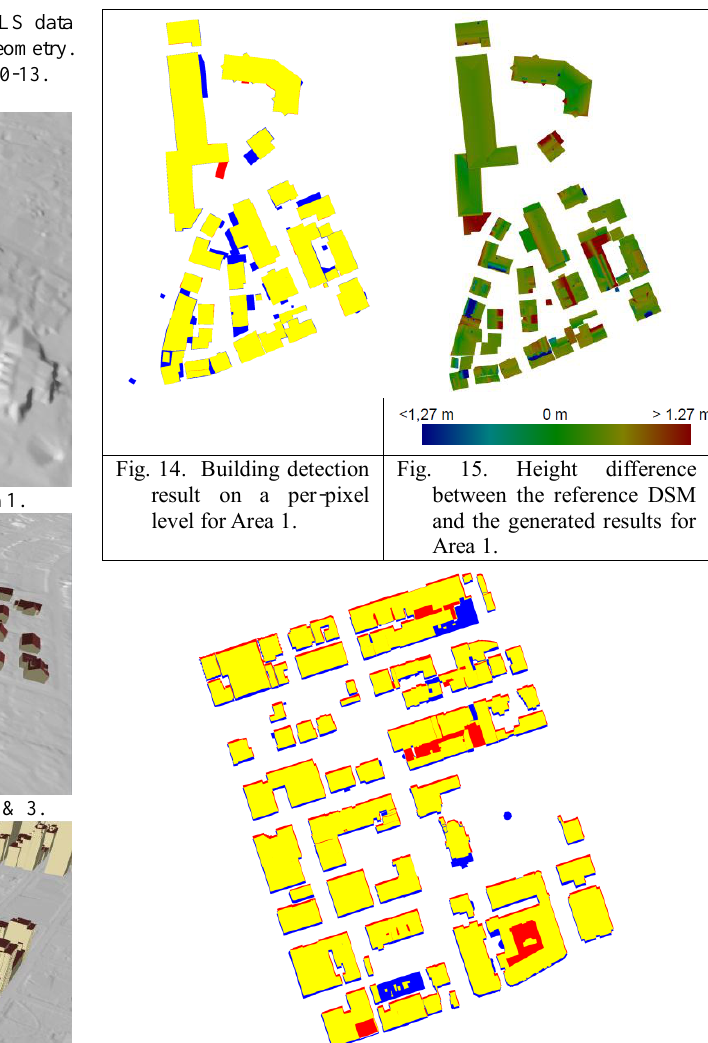
Fig. 16. Building detection result on a per-pixel level for Area 4.